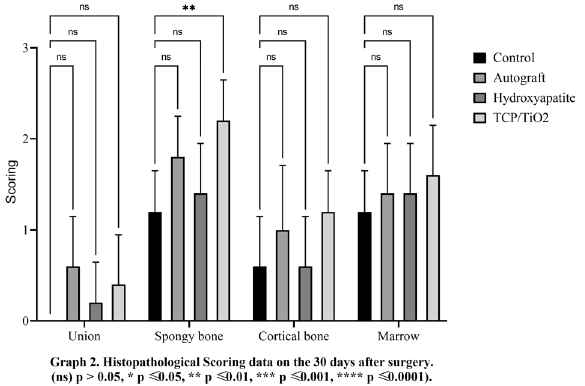
Fig. 4 Histopathological scoring data on the 60 days after surgery. (ns) p > 0.05, * p ≤ 0.05, ** p ≤ 0.01, *** p ≤ 0.001, **** p ≤